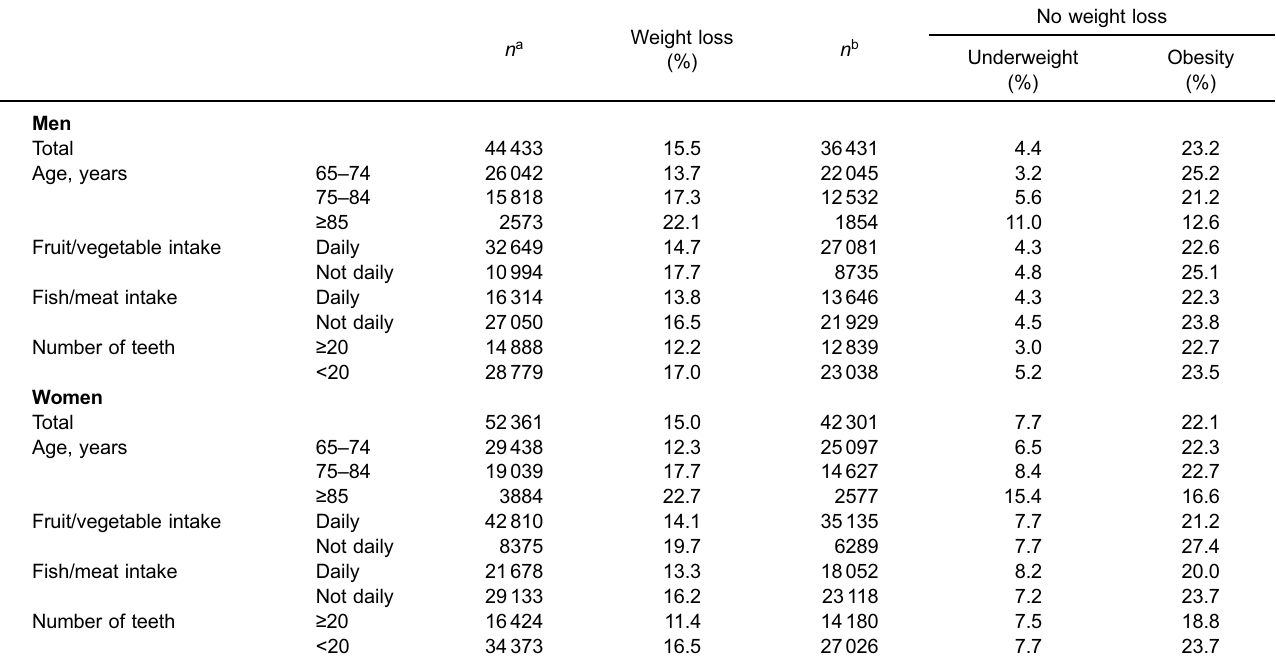
No weight loss n b n a Weight loss Underweight Obesity (%) (%) (%)